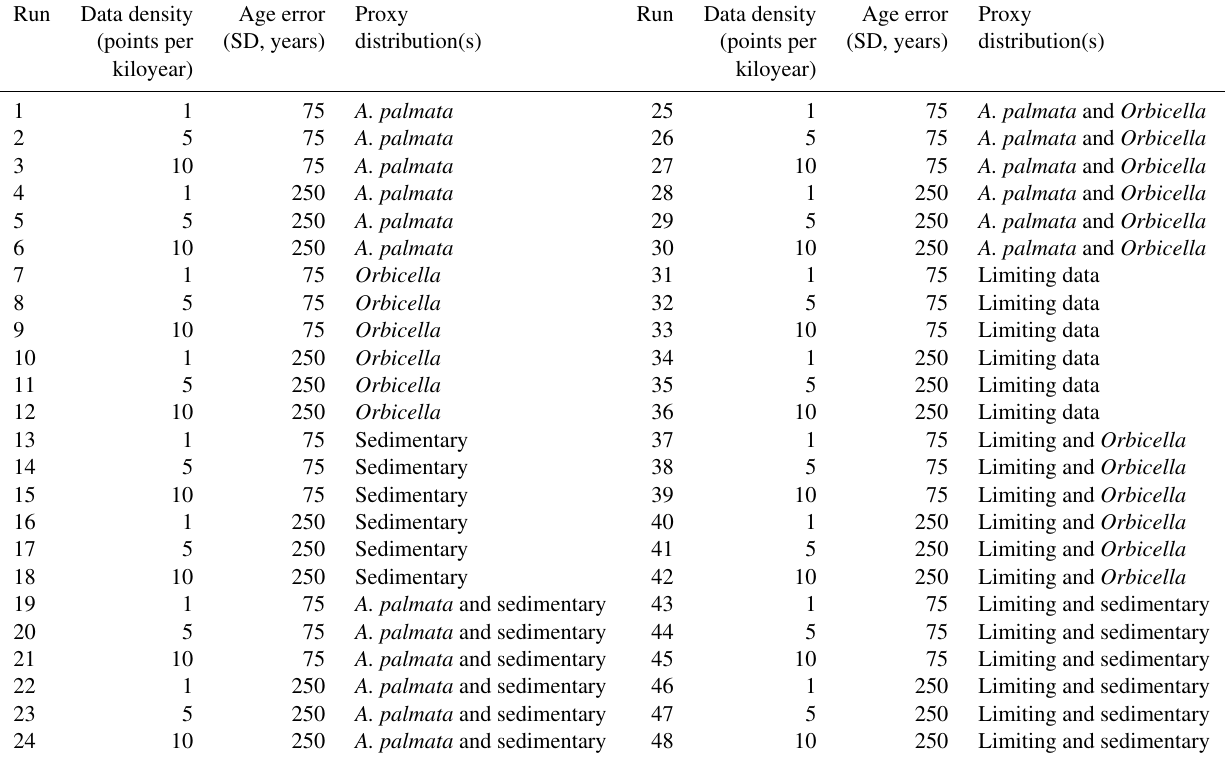
Table D1. Temporal data density, age uncertainty, and proxy distributions used to create synthetic data to perform the sensitivity tests of the nonparametric model. Runs 1–12 are also applied in the validation tests comparing the nonparametric and Gaussian models (Sect. 2.3.1). Run Data